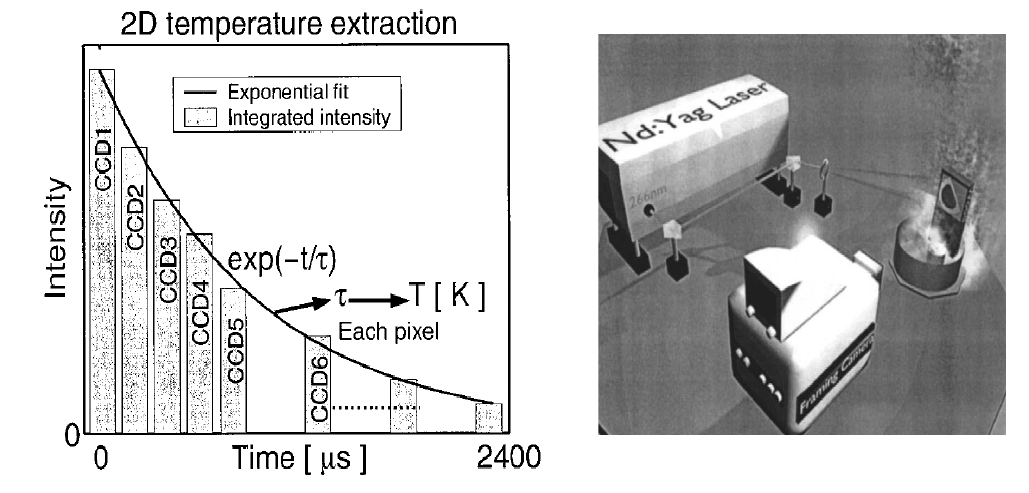
Figure 49 . Left: Curve fit for each pixel from intensities integrated from 8 CCD detectors; Right: Schematic for temperature measurement. Pictures taken from [40].